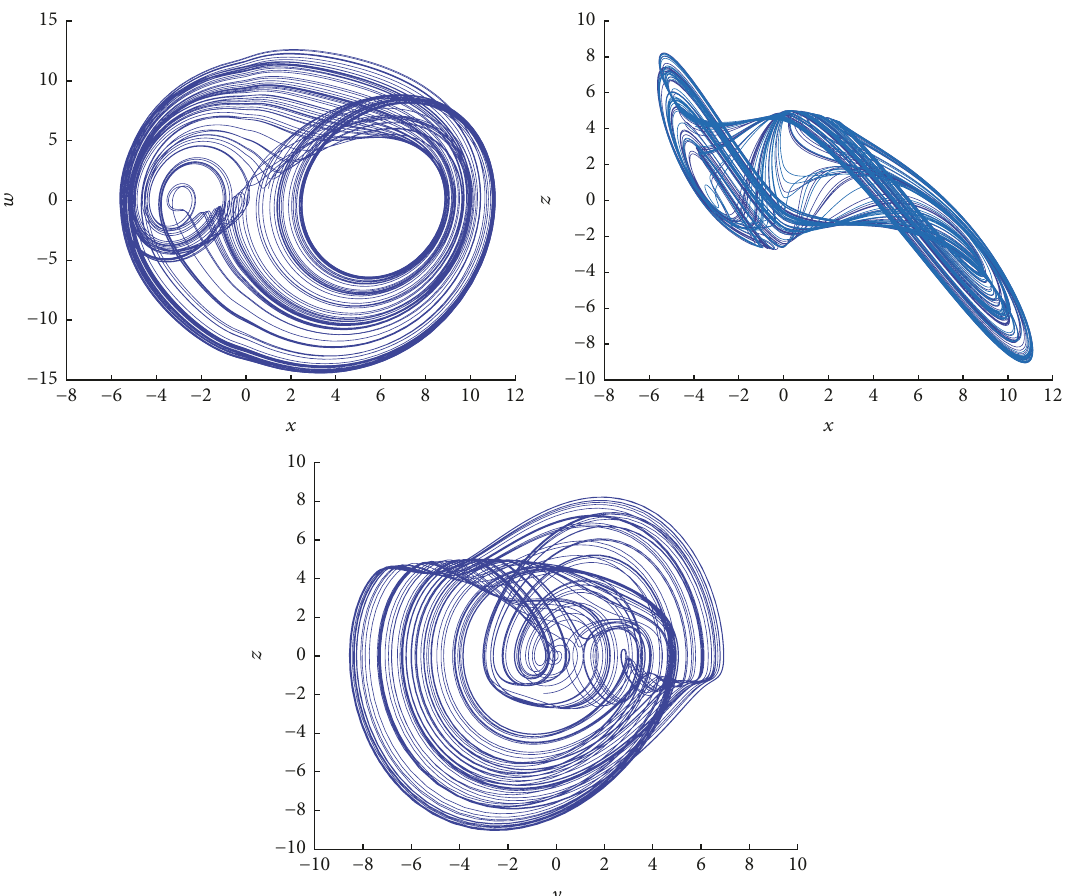
Figure 6: Projections of the attractor related to the adjusted hyperchaotic system (12) onto the spaces (𝑥,𝑤) , (𝑥,𝑧) , and (𝑦,𝑧) .